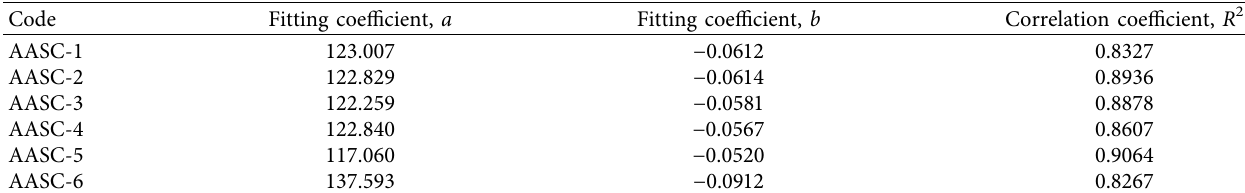
Table 12: Relative dynamic elastic modulus attenuation power function and pertinence